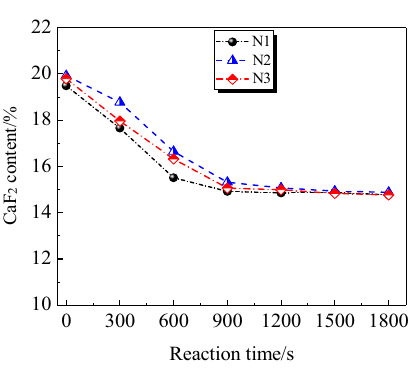
Figure 7: Changes of CaF 2 content in the